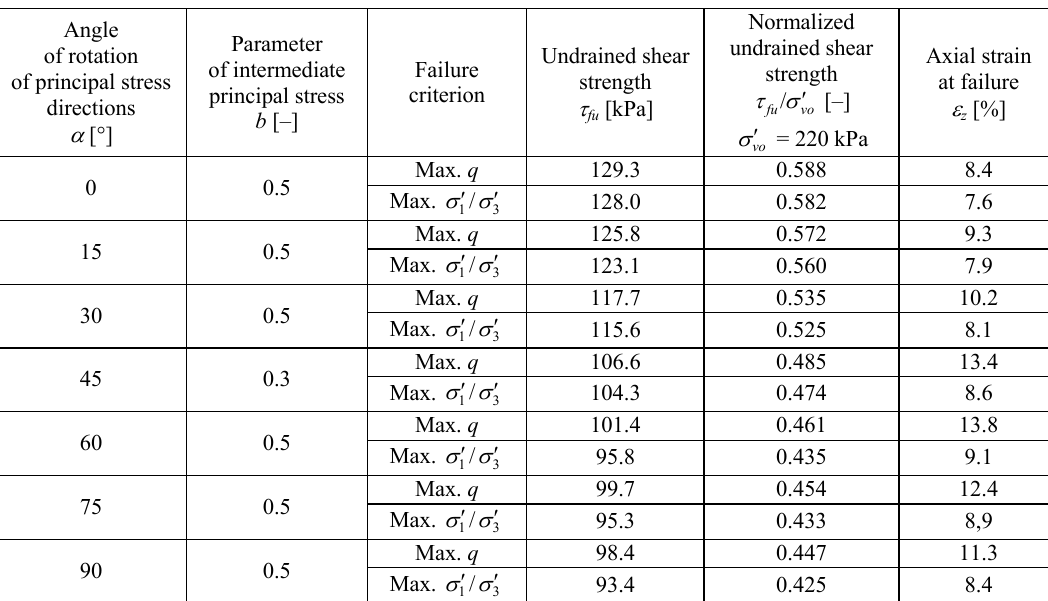
Table 3. Results of the HCA test for sandy silty